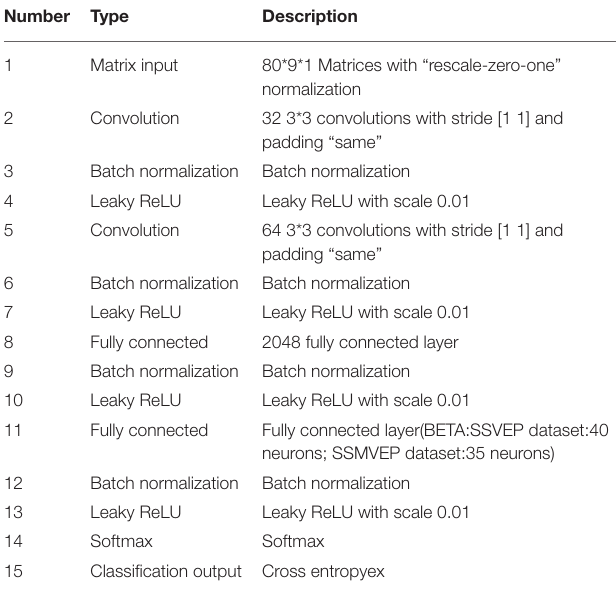
TABLE 1 | The structure of the CNN model used in the BETA:SSVEP dataset and SSMVEP